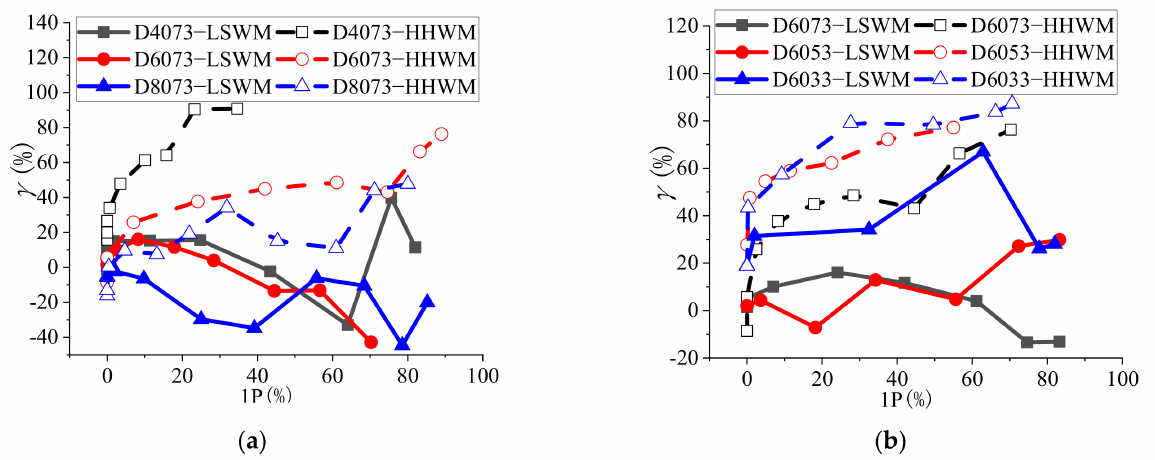
Figure 13. Values of γ − 1P for shells with different spans and rise-to-span ratios: ( a ) influence of the span; ( b ) influence of the rise-to-span ratio.